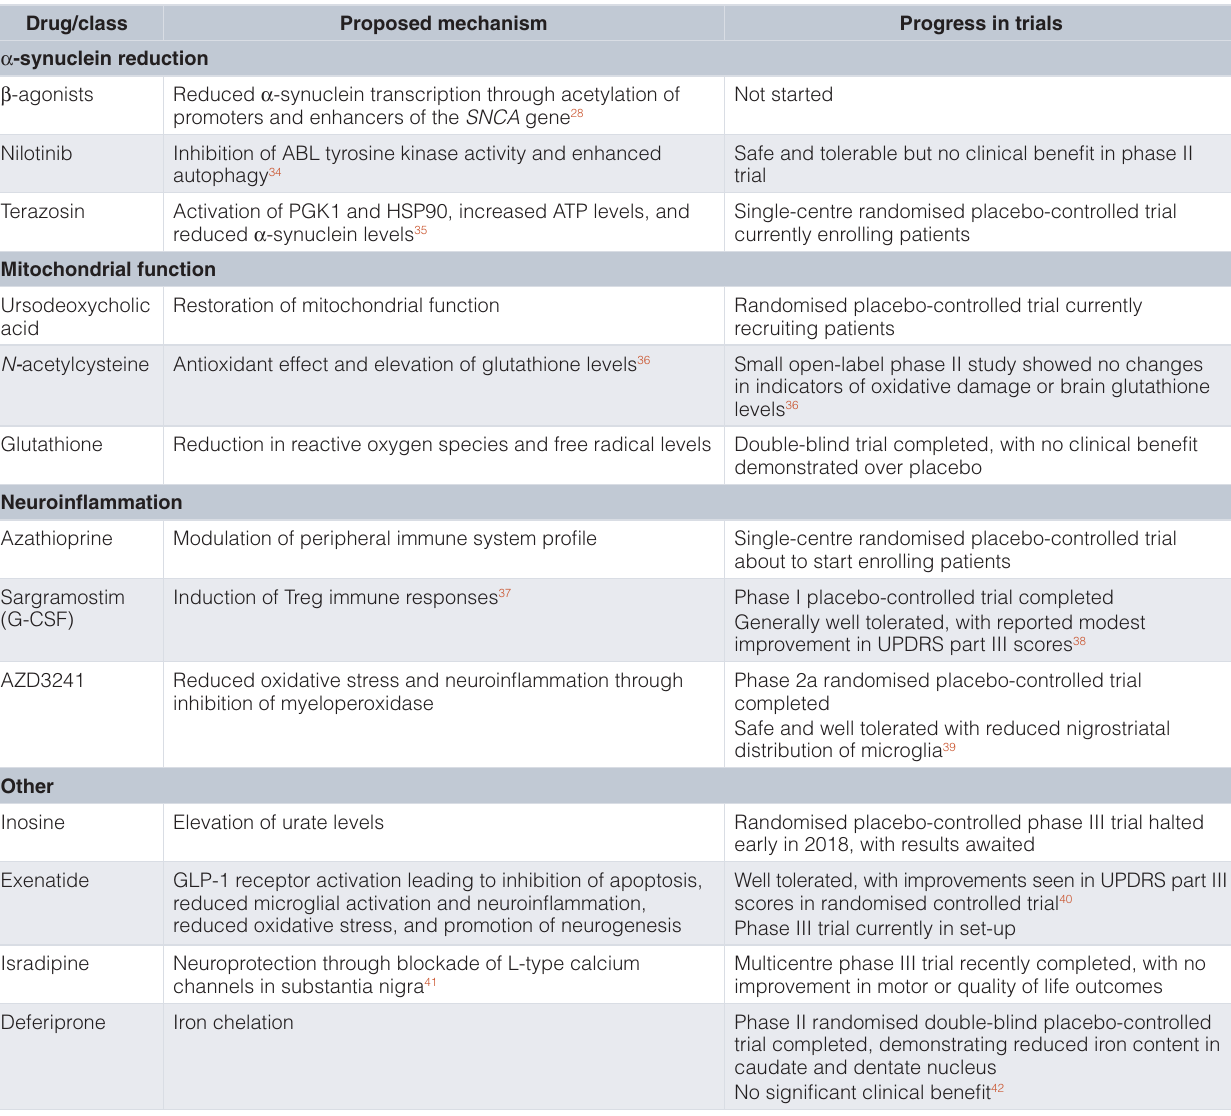
Table 1. Clinical trials of putative disease-modifying treatments for Parkinson’s disease.